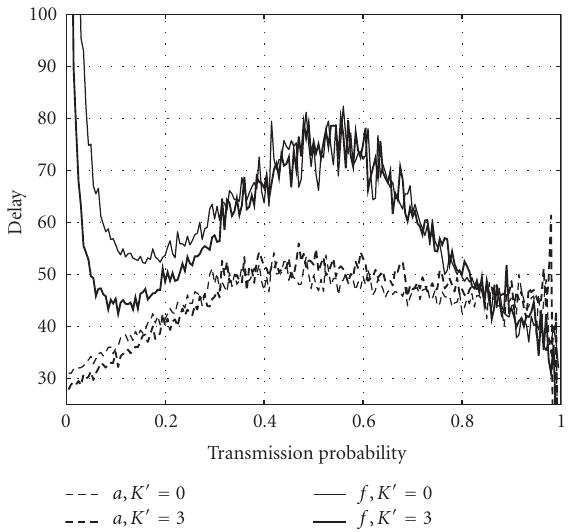
Figure 24: Delay of the dynamic ( K (cid:5) = 3) and static ( K (cid:5) = 0) cases for K = 4 with a reset of K ( K (cid:5) = 3) on node 7 of connection f (asymmetric network of Figure 11).